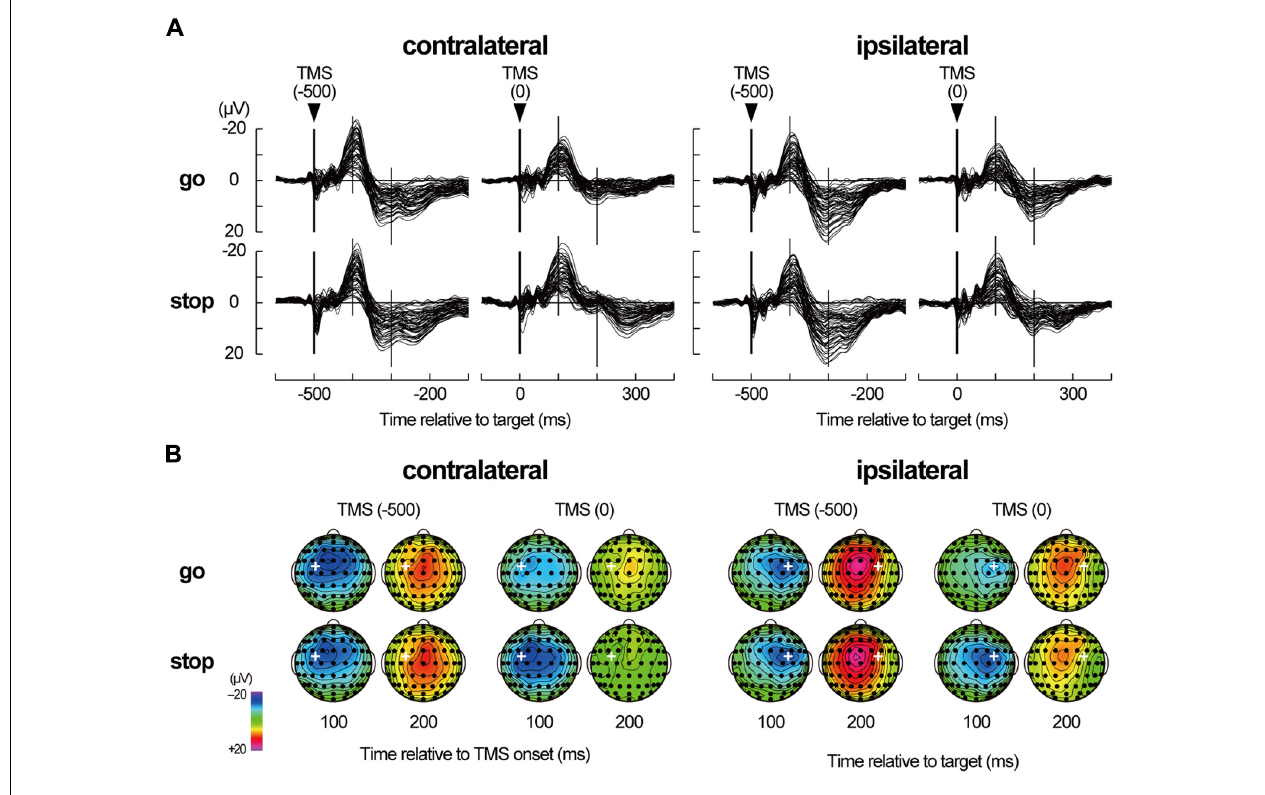
FIGURE 5 |TMS-evoked potentials. (A) TMS-evoked potentials (TEPs) during go/stop task with TMS at − 500 and 0 ms for six participants in a contralateral-TMS session (left 2 × 2 panels) and with TMS at − 500 and 0 ms for six participants in an ipsilateral-TMS session (right 2 × 2 panels). The vertical thick lines represent TMS onset, and the vertical thin lines represent 100 and 200 ms after the TMS onset. Time scales relative to target are displayed at the bottom. ( B) The scalp topographies